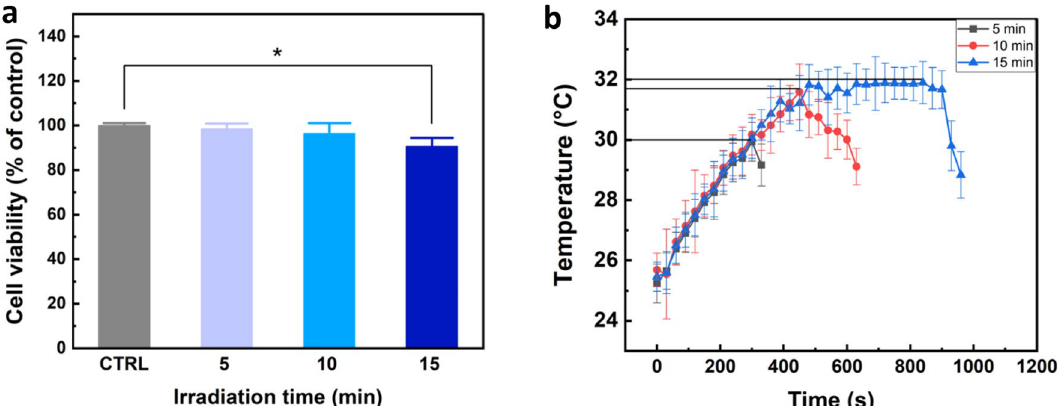
Figure 2. Response of normal cells (CCD-986sk) to 405 nm laser irradiation: ( a ) cell viabilities of various irradiation times (CTRL = control; ( * p < 0.05 vs. CTRL; N = 5) and ( b ) temperature development during laser irradiation on surface of CCD-986sk suspension in DMEM media.